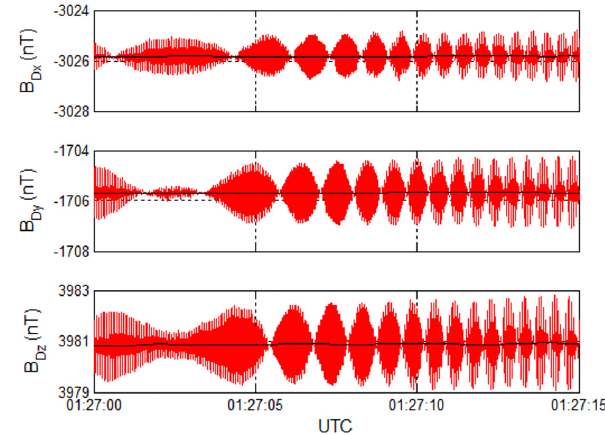
Fig. 8. Comparison of the ASPERA event measured at 1Hz (black) and 32Hz (red) in the differenced MAG data.